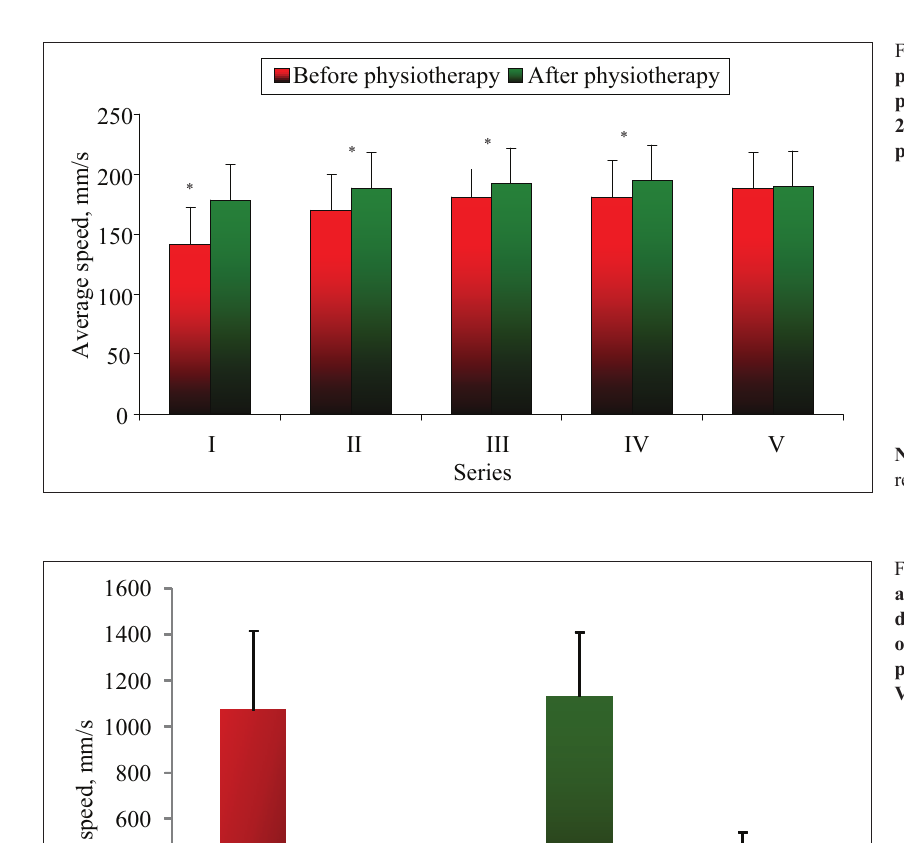
Figure 1. Reaction time (ms) averages in patients with Parkinson’s disease performing a task of 5 sets of 20 repetitions before and after physiotherapy. RT-simple task, RT-JT-complicated task